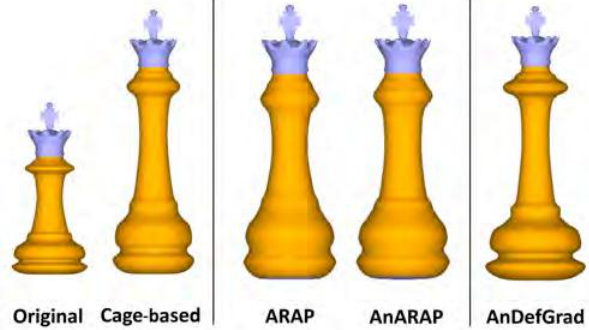
The original geometry (left) is linearly elongated using single cage-based deformation. Regular ARAP deformation and anisotropic ARAP deformation (AnARAP) results are shown in comparison. Note that feature sharpness is lost using an isotropic energy formulation. Overall, ARAP—with or without anisotropy— does not perform as well at sharp edges as the anisotropic deformation gradient modeling (AnDefGrad).